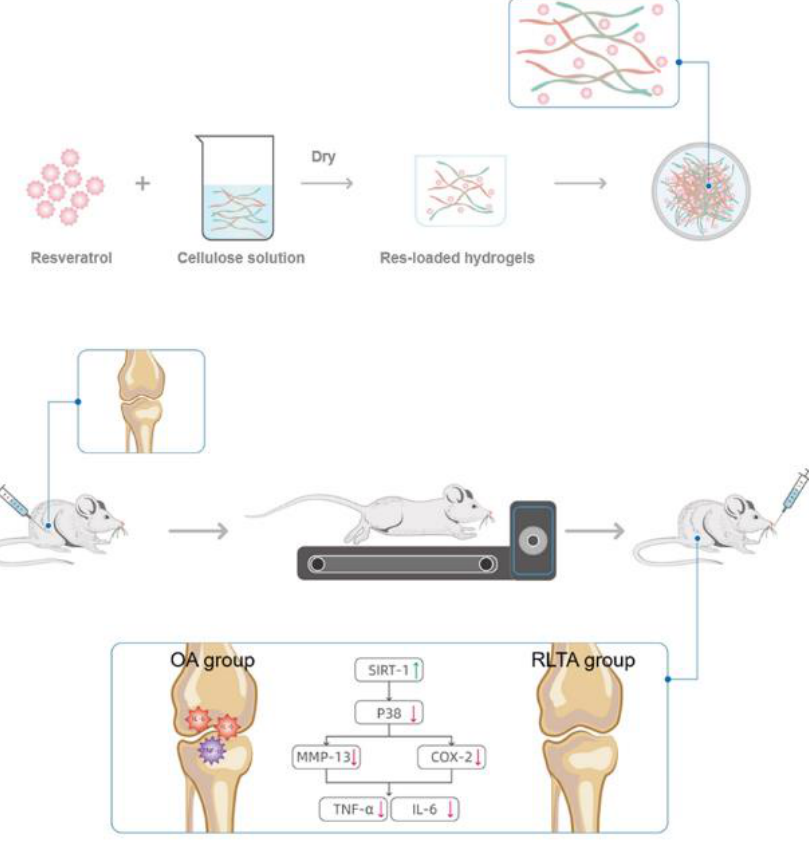
Scheme 1. Schematic diagram of the synthesis process of RLTA and the regulatory mechanism of RLTA in the treatment of sports